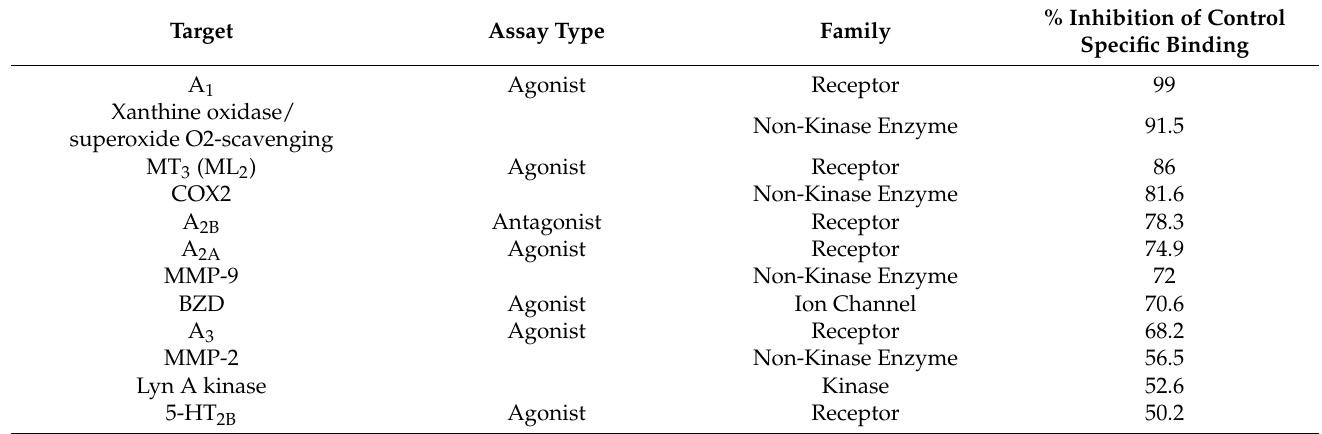
Table 4. Binding of 7,8-DHF to proteins assessed in BioPrint ® Profile Panel. The effect of 7,8-DHF at a concentration of 10 µ M was examined against members of several protein families, including G Protein-Coupled Receptors (GPCRs), transporters, ion channels, nuclear receptors, kinases, and non-kinase enzymes. The table presents results showing an inhibition of control specific binding higher than